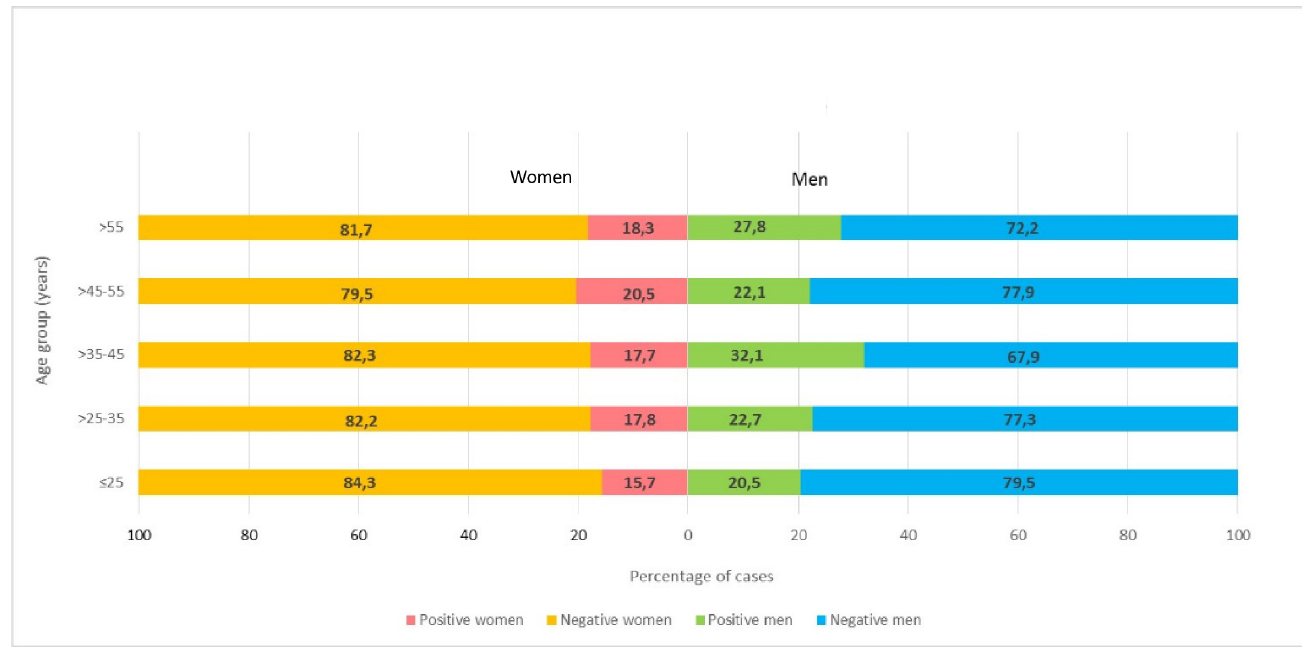
Fig 2. Age and sex cumulative prevalence of SARS-CoV-2 cases (IgG positive and/or RT-PCR positive). The differences by age group were not significant.